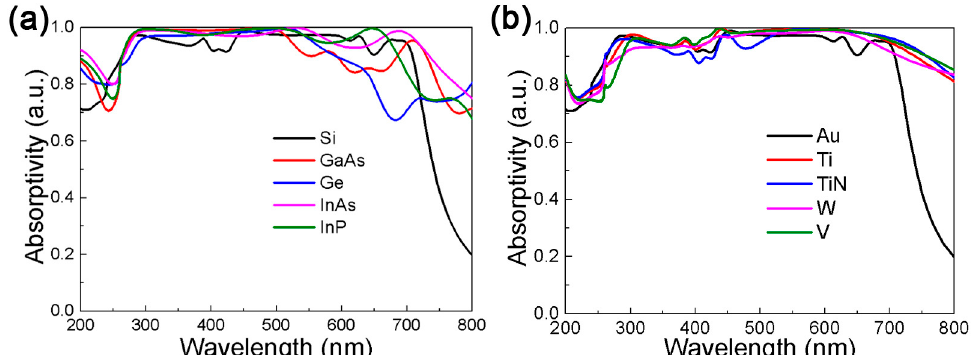
Figure 8. ( a ) The absorption spectrum when keeping the substrate unchanged and replacing Si with other dielectrics such as GaAs, Ge, InAs and InP. ( b ) The absorption spectrum when keeping the Si unchanged and replacing Au substrate with refractory materials such as Ti, TiN, W, V.